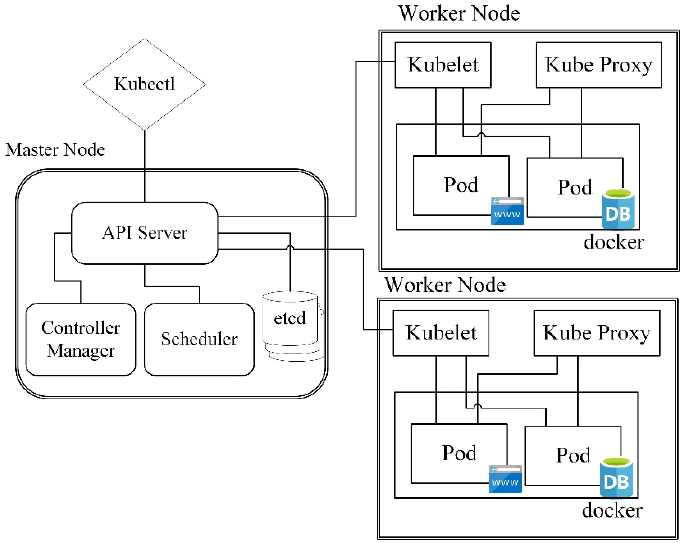
Figure 4. Schematic representation of the Kubernetes